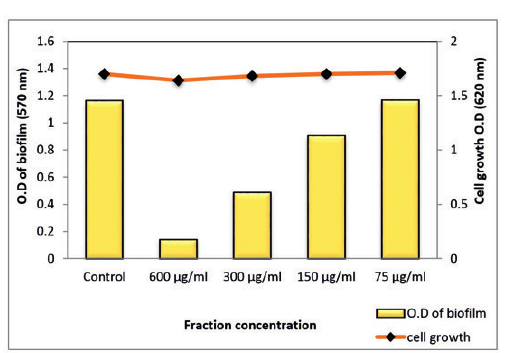
Fig. 13. Effect of sub-MICs of polyphenol fraction Z. spina-christi on biofilm formation of P.